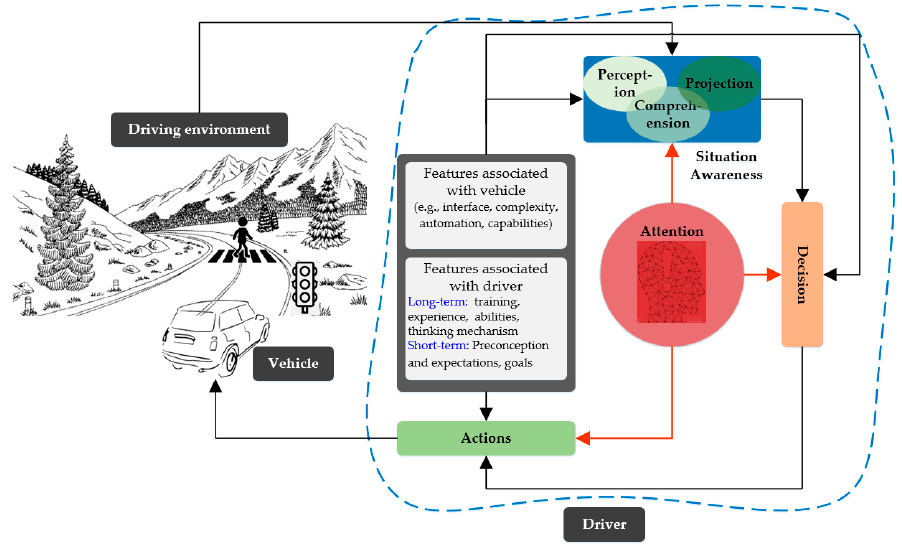
Figure 1. Driving process.